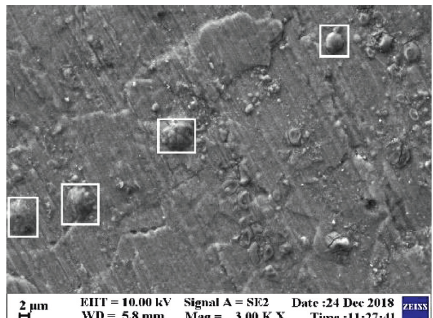
Figure 16: Experimental bulging phenomenon of SEM (3000 times) micromorphology of the magnesium alloy plate heated by cathodic protection.